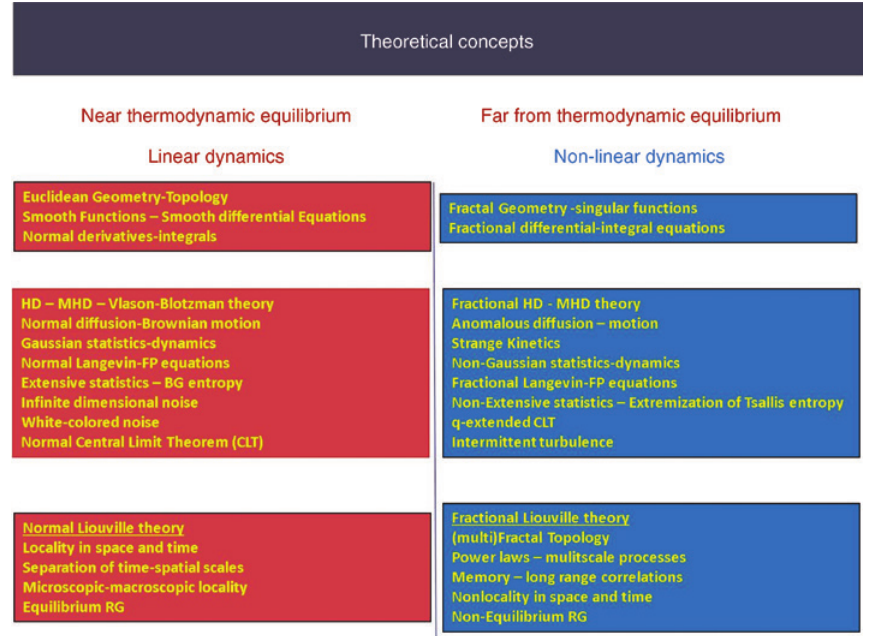
Figure 4: In this table we summarize the q -extension of dynamics and statistics as the system departs from the state of thermodynamic equilibrium and lives at meta equilibrium stationary